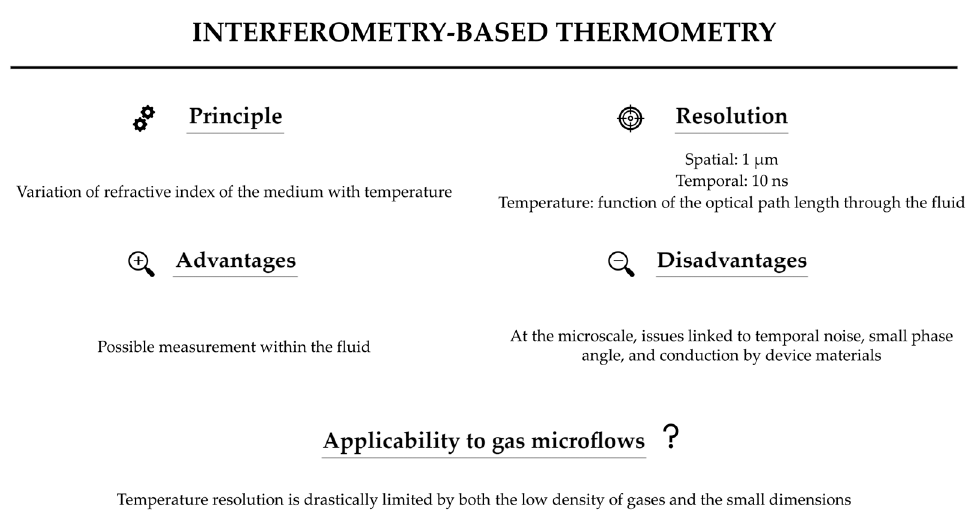
Figure 22. Features of interferometry-based thermometry. Values of spatial and temporal resolutions are from [117].